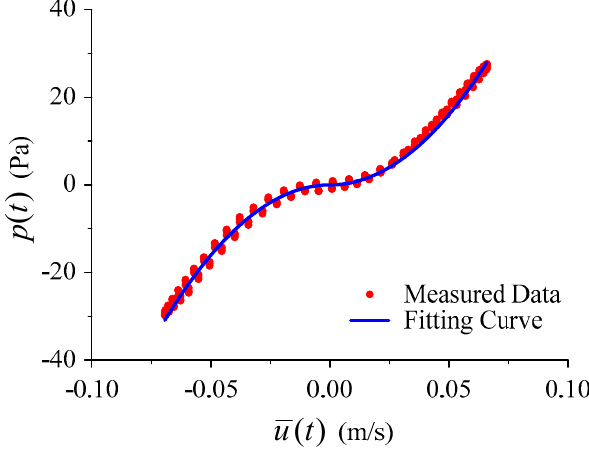
Figure 5. A comparison of the measured pressure data and the fitting curve for the slot-shaped opening of 1.25% opening ratio and 1.3 s wave period. Table 3. Fitted values of C f for the six top openings tested in the present study.